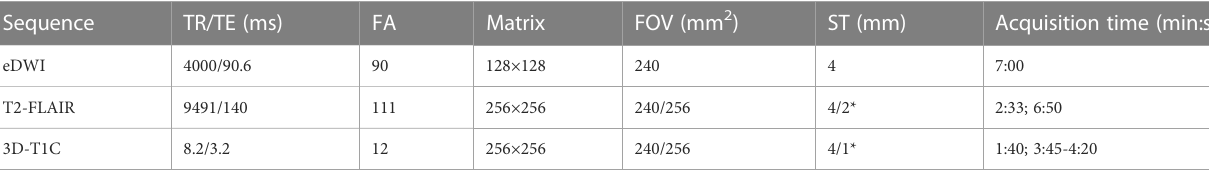
TABLE 1 Main MRI sequences and